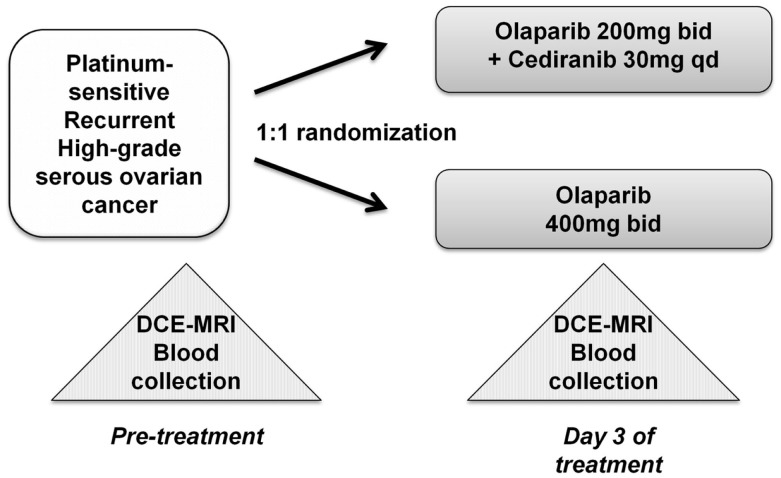
Treatment schema and correlative studies. Peripheral blood mononuclear cell (PBMC), whole blood DNA, and plasma samples were collected prior to initiation of the study drug(s), and all patients underwent DCE-MRI imaging. Follow-up sampling was done on day 3 of treatment.